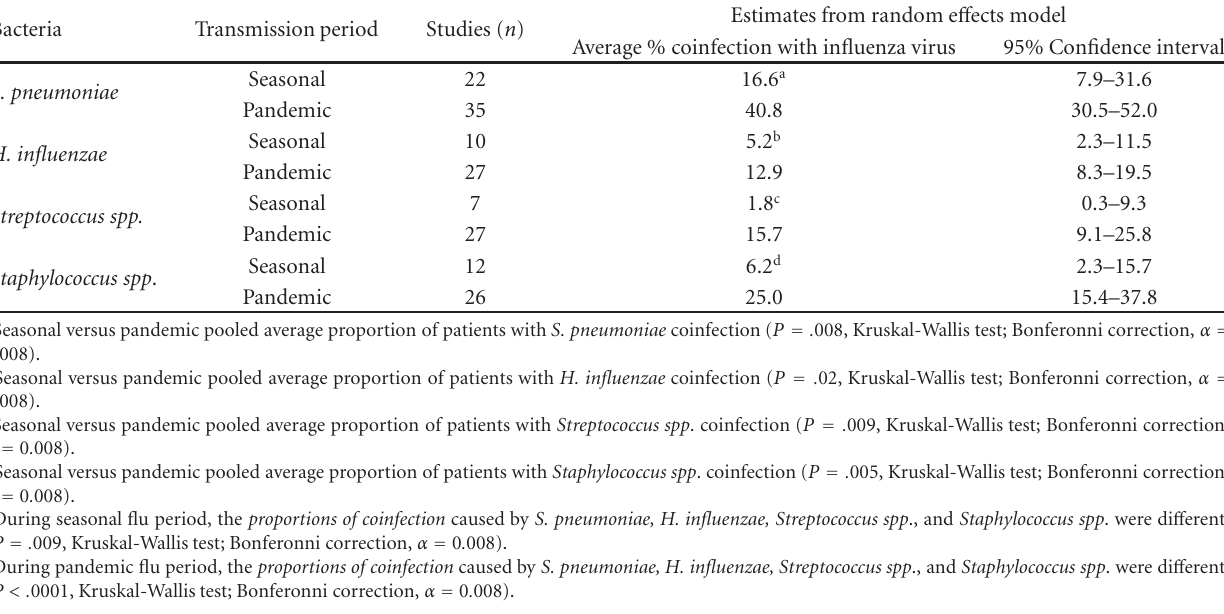
Table 2: Pooled results of coinfecting bacterial pathogens identified with influenza virus during seasonal and pandemic influenza periods. Bacteria Transmission period Studies ( n )